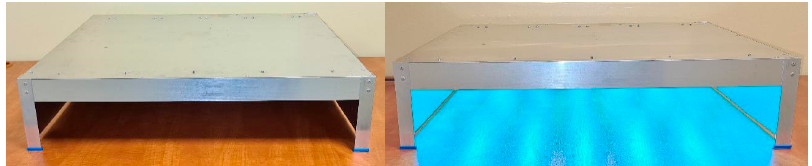
Figure 4. Photographs of the built sterilizer.